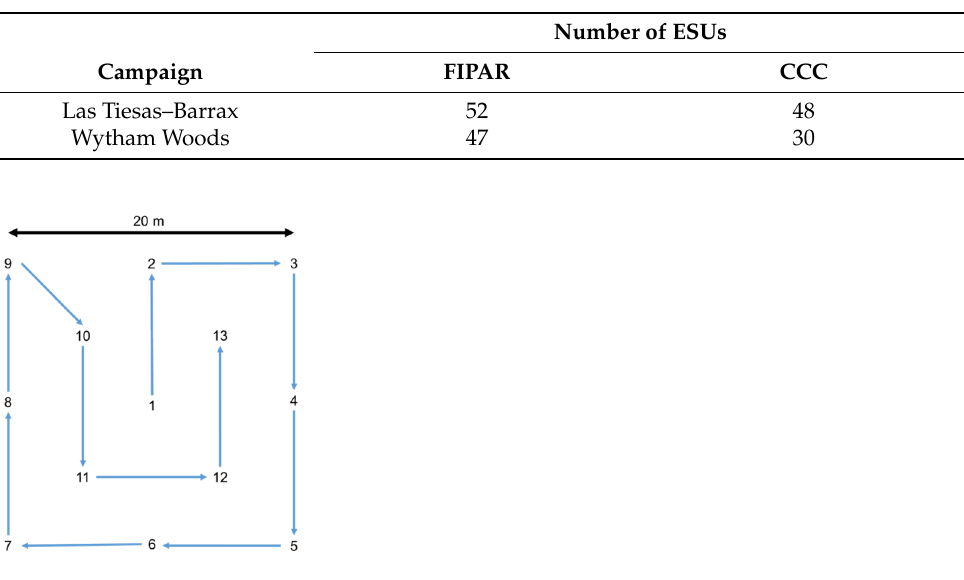
Figure 3. Spatial sampling scheme followed within each ESU, consisting of 13 sampling locations arranged in a systematic pattern, and a further two randomly located sampling locations (not shown).